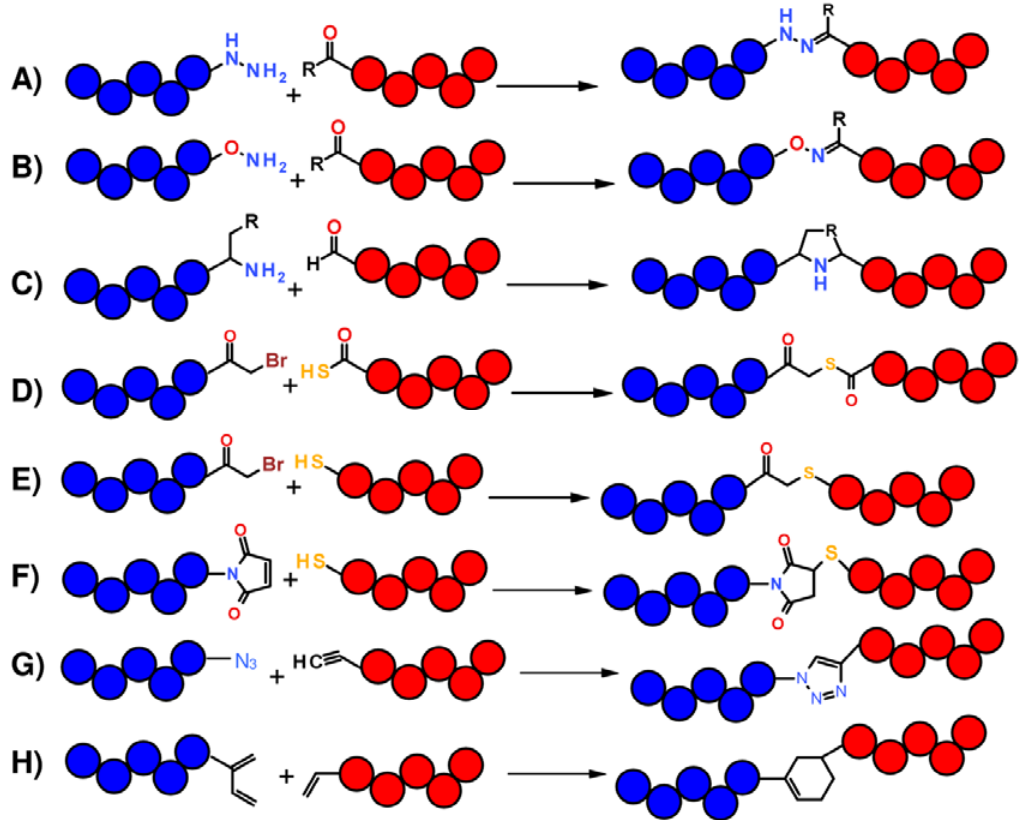
Figure 2. Schematic representation of chemoselective reactions useful for